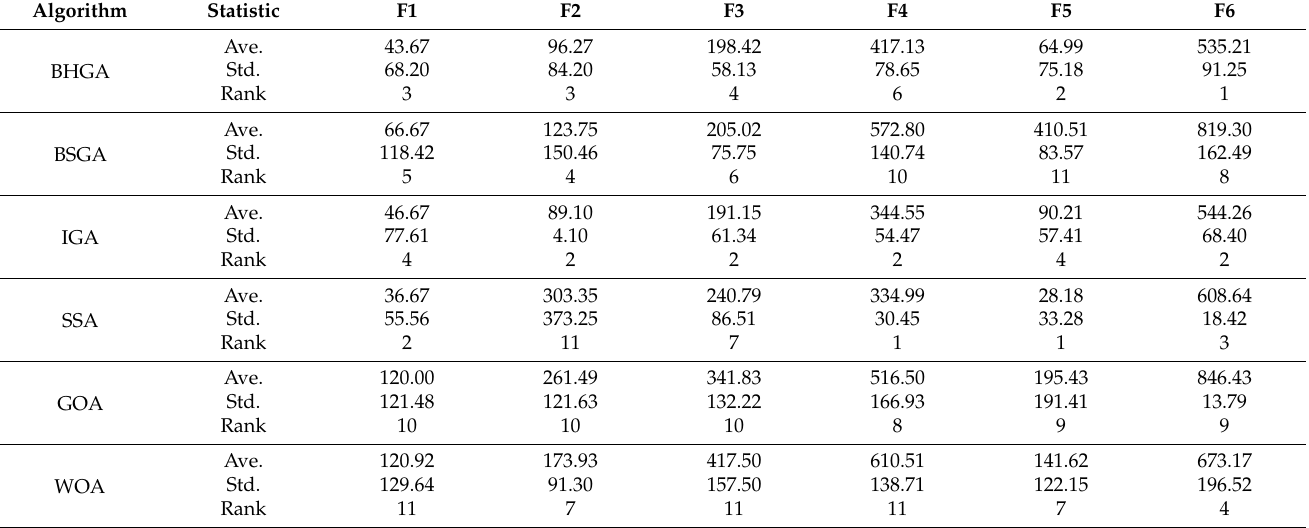
Table 4. Statistical results of composite benchmark